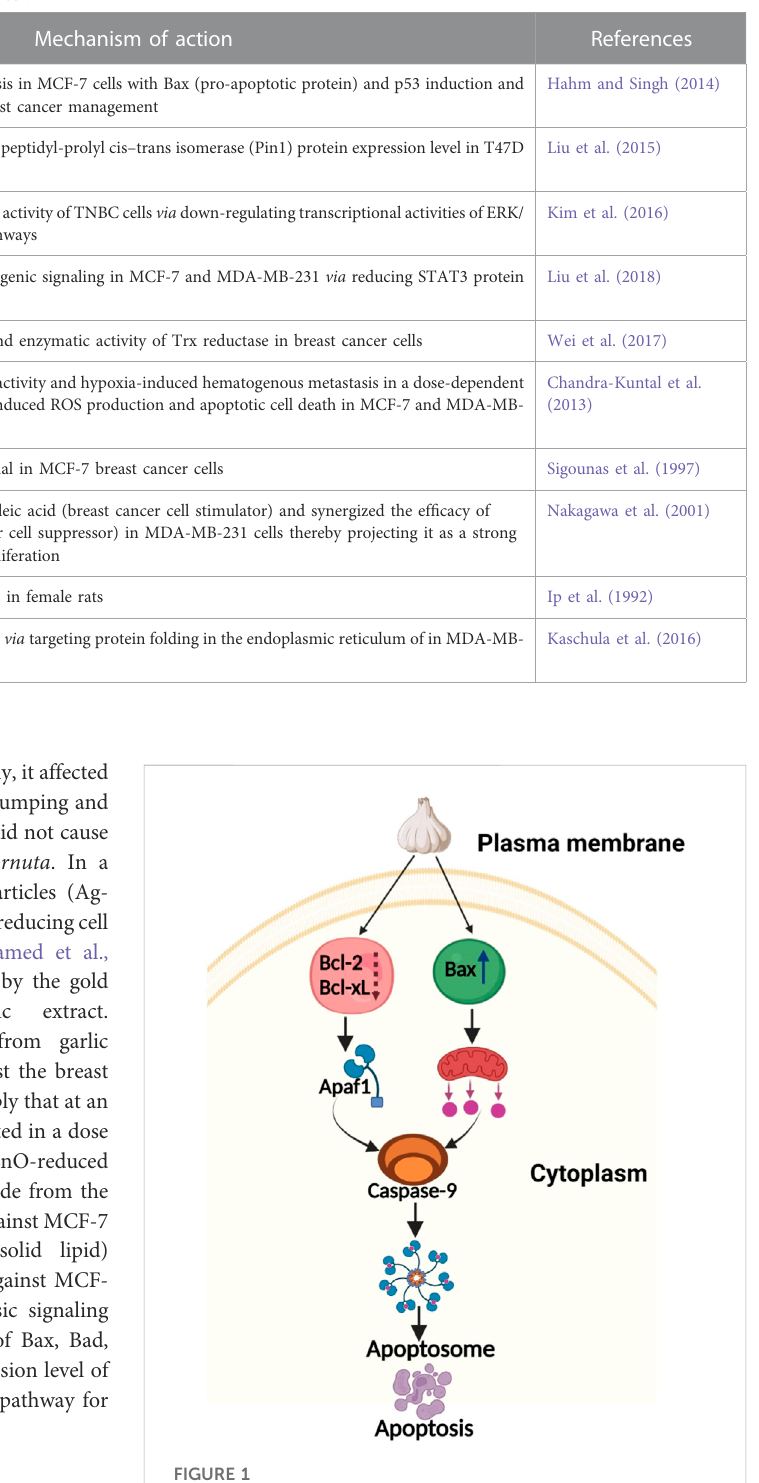
FIGURE 1 Proposed pathway for garlic induced apoptosis in breast